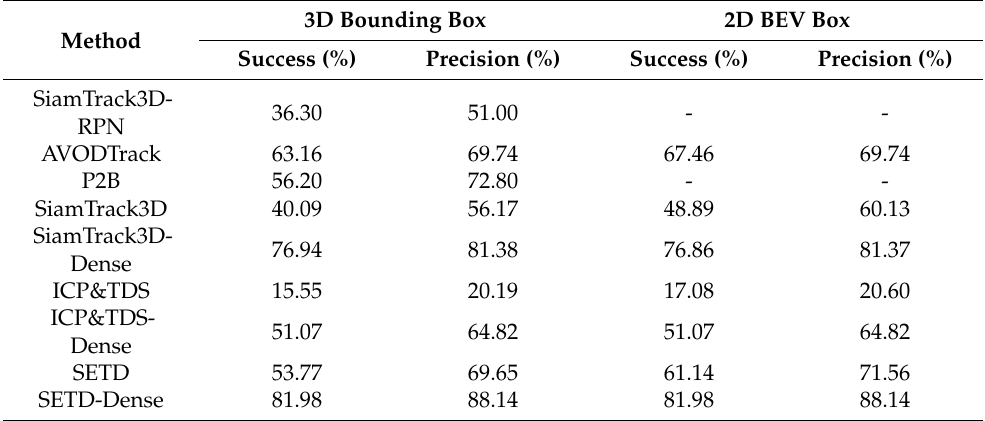
Table 2. Performance comparison with the state-of-the-art methods on KITTI. The OPE evaluations of 3D bounding boxes and 2D BEV boxes are reported.